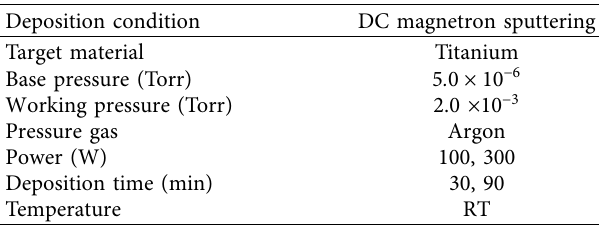
Table 4: Experimental parameters of DC magnetron sputtering.